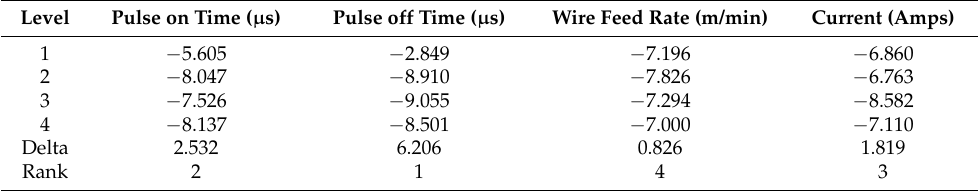
Table 8. Response table for signal to noise ratios (surface